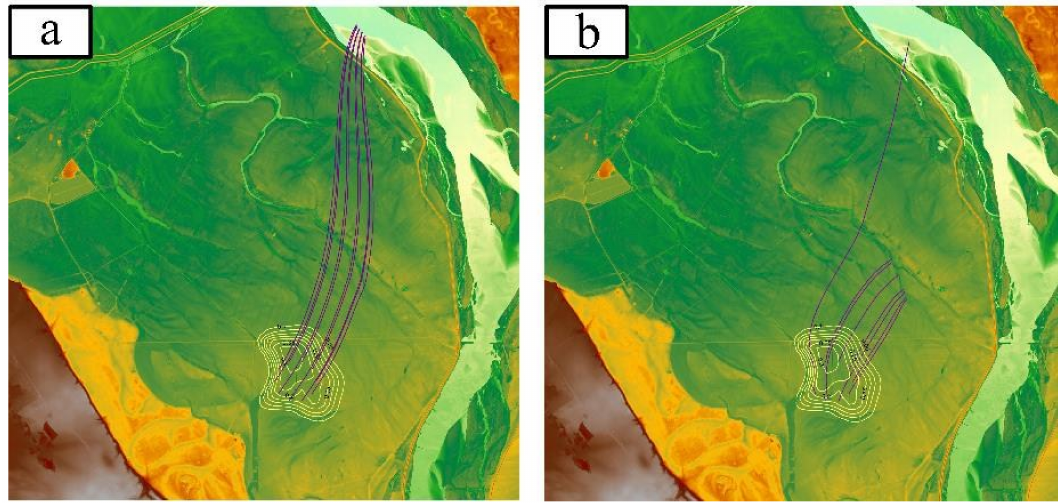
Figure 7. Particle path lines simulating contaminant transport: ( a )—period with normal precipitation; ( b )—period with intense